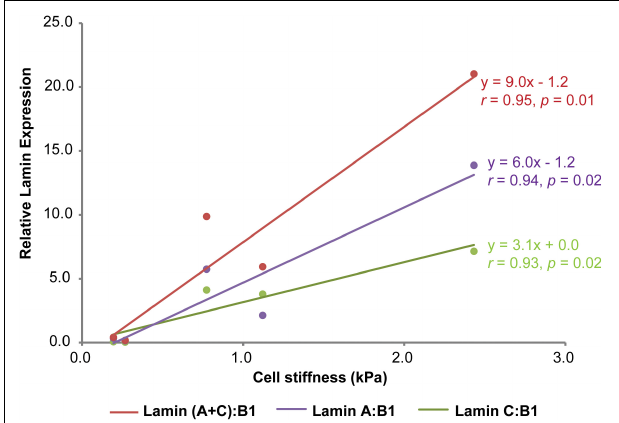
FIGURE 2 | Correlations between lamin A:B1, C:B1, (A + C):B1, and C:A and cell stiffness. Relative protein expression for lamins A, B1, and C was determined via western blot and densitometry analysis from protein lysates (10 µ g) extracted from osteoblastic (MG-63), fibroblastic (NHF), ovarian (KGN), renal (HEK-293T) and neuronal (SH-SY5Y) cell lines using a urea-sodium dodecyl lysis buffer, as described elsewhere (Gonzalez-Cruz et al., 2018). Individual protein expressions were normalized to beta tubulin loading control expression prior to isoform ratiometric analyses. Mechanophenotype was determined by measuring the elastic modulus of MG-63, NHF, KGN, HEK-293T, and SH-SY5Y cells via atomic force microscopy single-cell indentation. Lamin B1, a mechanically unresponsive lamin isoform that is important for nuclear lamina assembly was used as a normalizing factor to re-assess the contributions of lamin A and C to whole-cell mechanophenotype (Lammerding et al., 2006). Data points shown as arithmetic means. Correlation analyses between cell stiffness and ratiometric lamin expression were determined by calculating Pearson’s r coefficient for each set of comparisons. Statistical significance for the r coefficients was determined from Student’s t distribution probability function